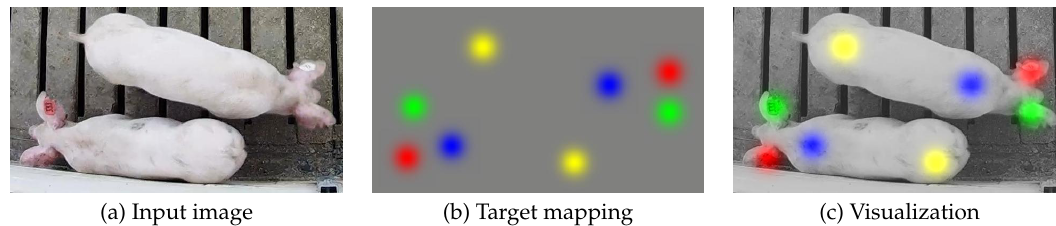
Figure 1. The original image ( a ) is mapped to a four-channel output ( b ), where the location of the left ear, right ear, shoulder, and tail are represented by Gaussian kernels in channels 1–4 of the output, respectively. Note that the four colors used in ( b ) are purely for visualization of the four separate channels of the target image. The overlay in ( c ) is provided to illustrate the locations relative to the original